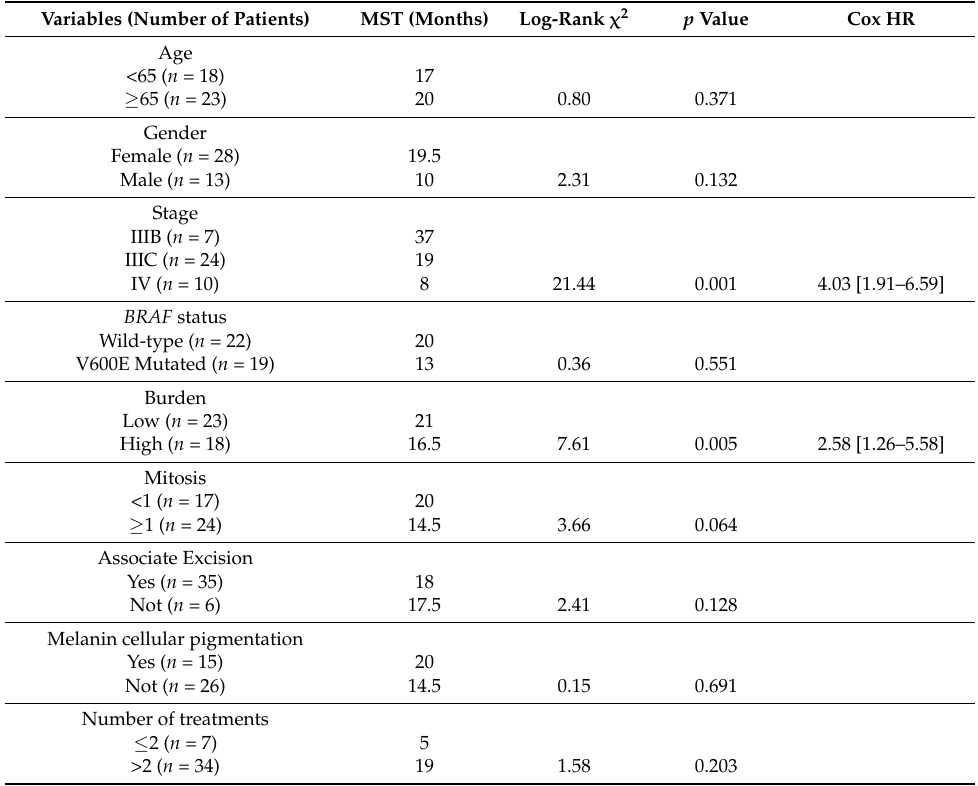
Table 2. Survival according to age, gender, stage, BRAF V600E status, burden, mitosis, associated excision, cellular melanin pigmentation, number of treatments. Variables (Number of